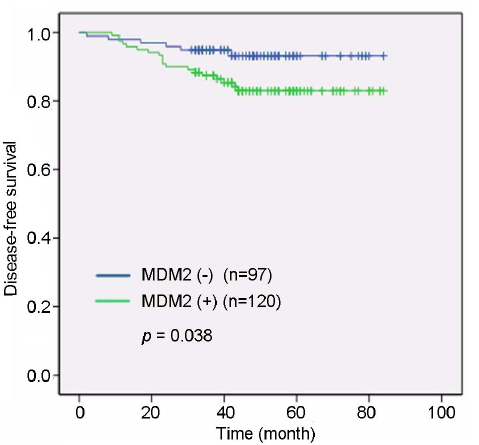
Figure 4. MDM2 expression levels were significantly correlated with disease-free survival. Univariate analysis showed that patients with MDM2-positive expression had shorter disease-free survival times than patients with tumors that were MDM2-negative (P=0.038).